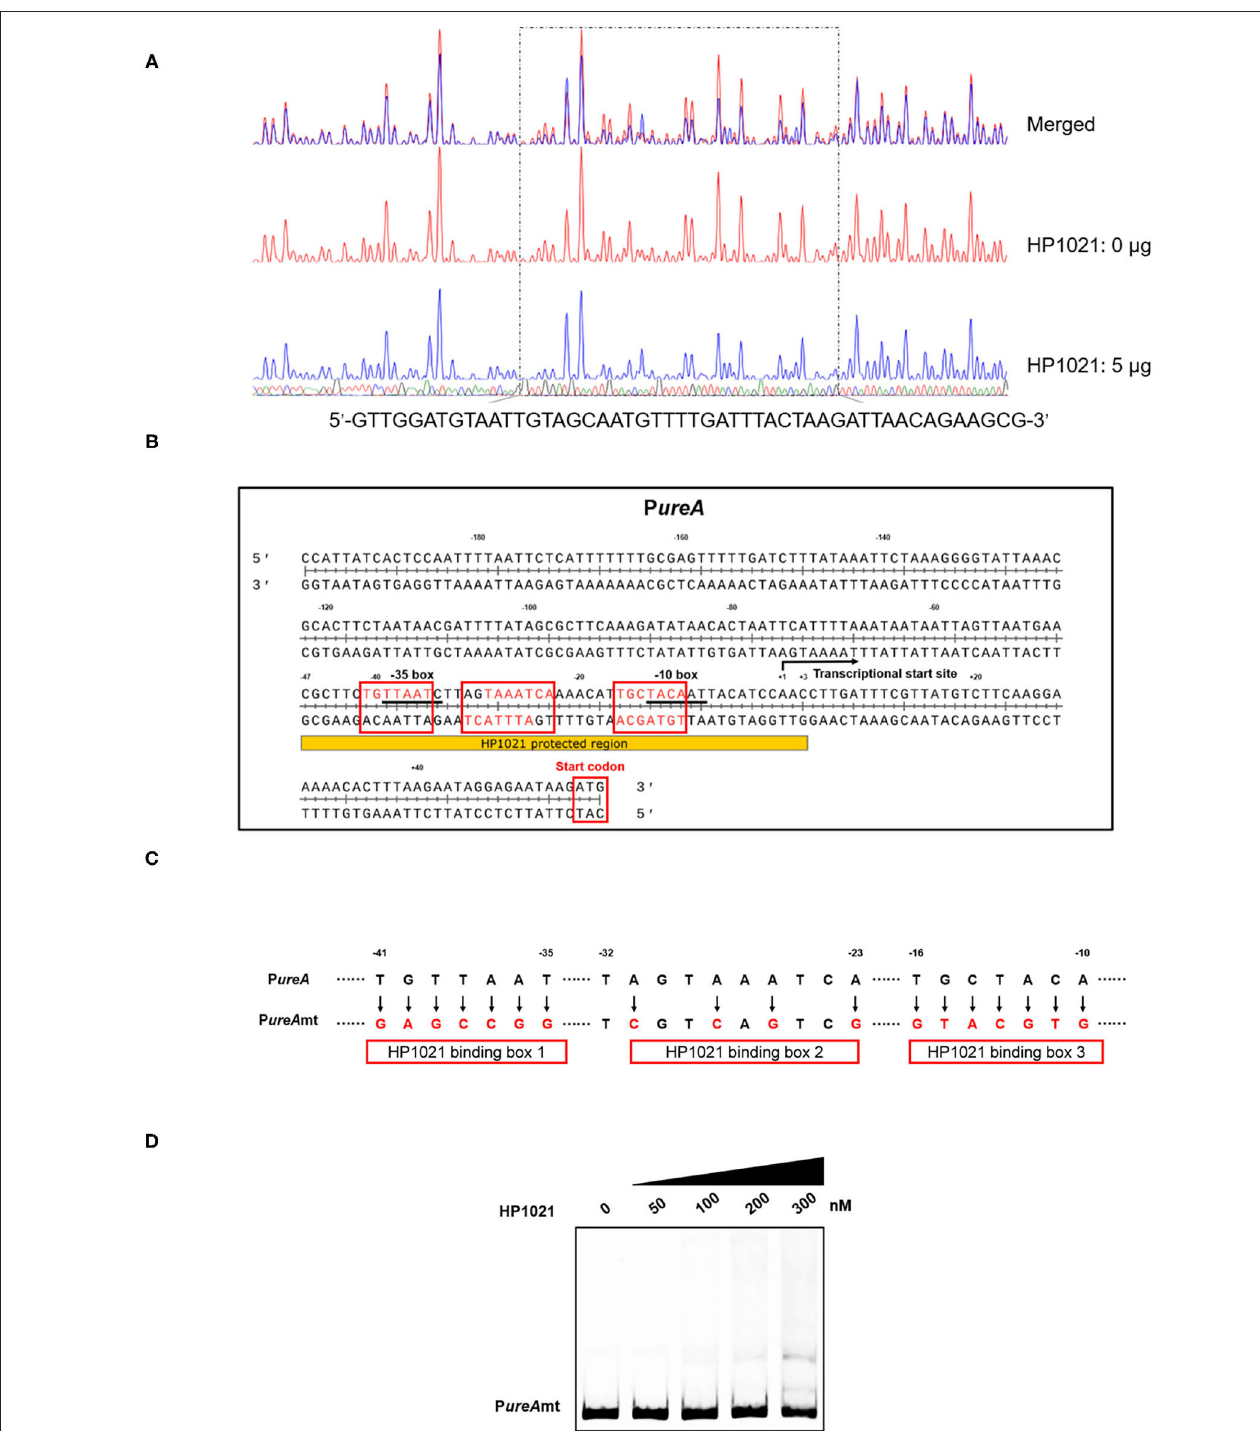
FIGURE 6 | Determination of the binding site of HP1021 on the ureAB promoter region. (A) Dye primer-based DNase I footprinting assay of HP1021 and the ureAB promoter region. Protected fluorograms were obtained by incubating fragments of the ureAB promoter region with or without HP1021. The nucleotide sequence of the protected region is shown below. (B) Analysis of the HP1021 binding site and consensus HP1021 binding boxes. Sequence shown is P ureA with numbers represent the position related to the transcriptional start site. The consensus − 10 and − 35 box are underlined, while the HP1021 protected sequence is indicated. The transcriptional start site was indicated with arrow; three HP1021 binding boxes were indicated with red box, while the putative consensus HP1021 binding sequences within were shown with red. (C) Mutagenesis of the HP1021 binding site. The replaced nucleotides are indicated with arrows and the mutation probe (P ureA mt) is shown. (D) Electrophoretic mobility shift assay (EMSA) results of the interaction between HP1021 and P ureA mt probe. P ureA mt labeled at the 5’-end with AF700 was incubated with increasing concentrations of Strep-HP1021 protein. The arrow indicates P ureA mt probe bands.